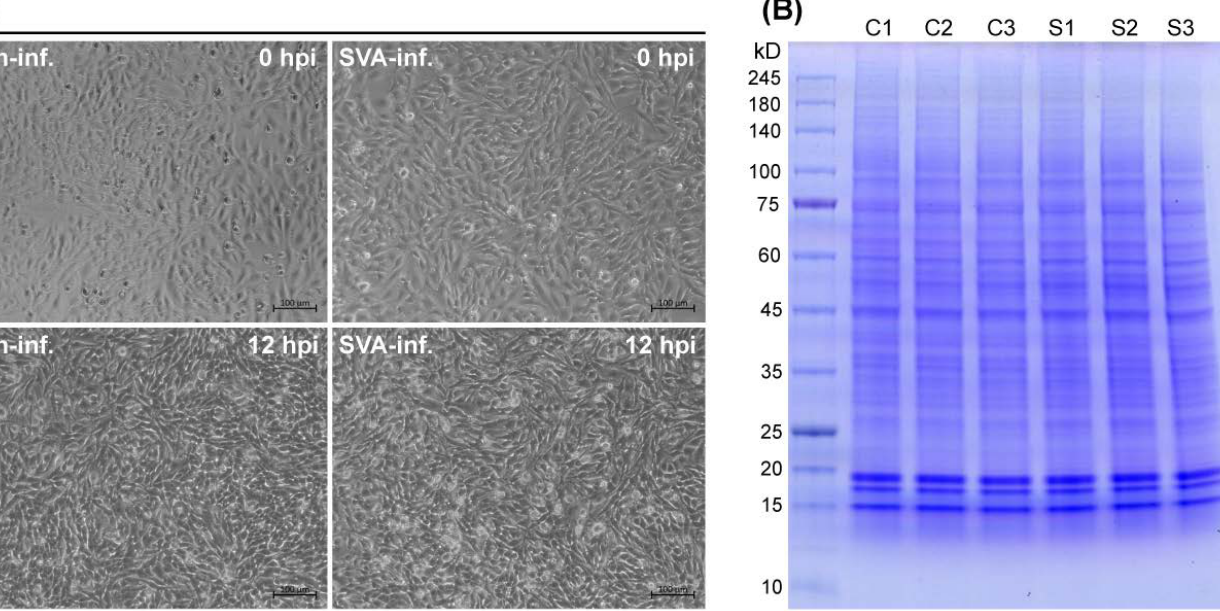
Figure 1. Sample preparation for SDS-PAGE analysis. SVA- and non-infected BSR-T7/5 cells at 0 and 12 hpi ( A ). Cell samples are collected from six groups for further lysis, followed by SDS-PAGE analysis ( B